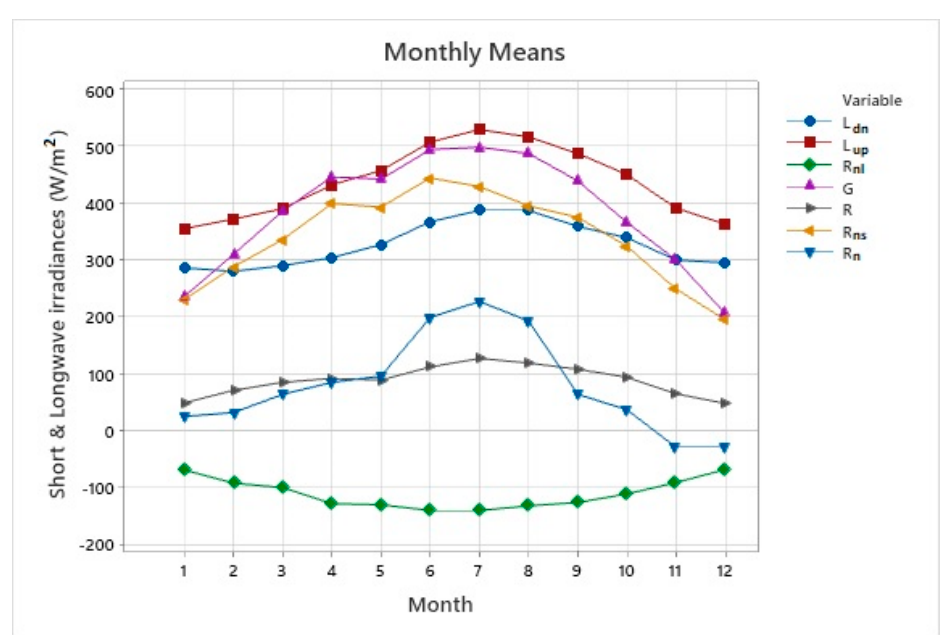
Figure 7. Monthly mean values of the short and longwave irradiances including the net allwave irradiances in W/m 2